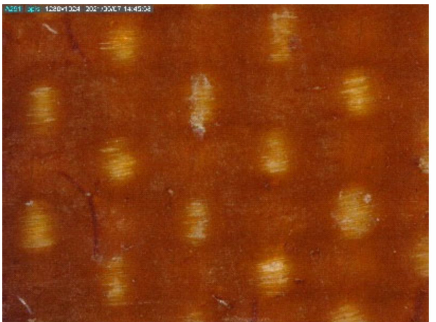
Figure 6. MO image of the surface of the textolite material with clearly marked degradation effects (40 times magnification). Shiny bundles of fibres of the textile support are visible. They appeared on the surface of the material after the top layer of the resin had melted.